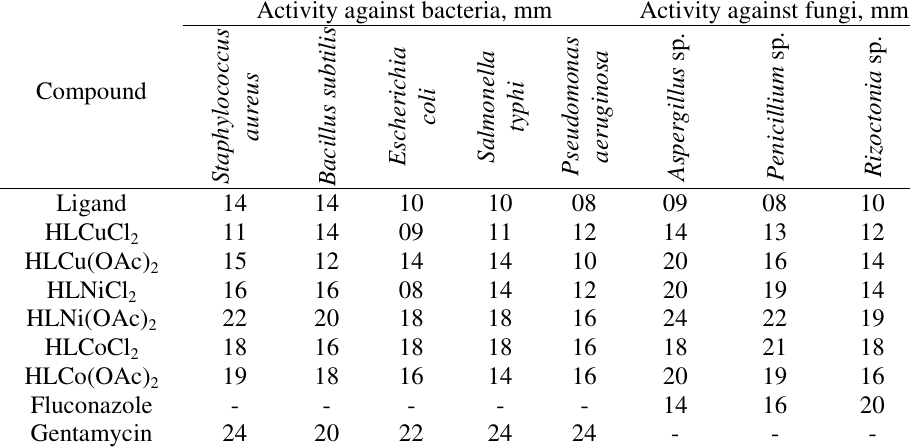
Table 1. Antimicrobial results of Schiff base ligand and its metal complexes at 10 µ gmL −1